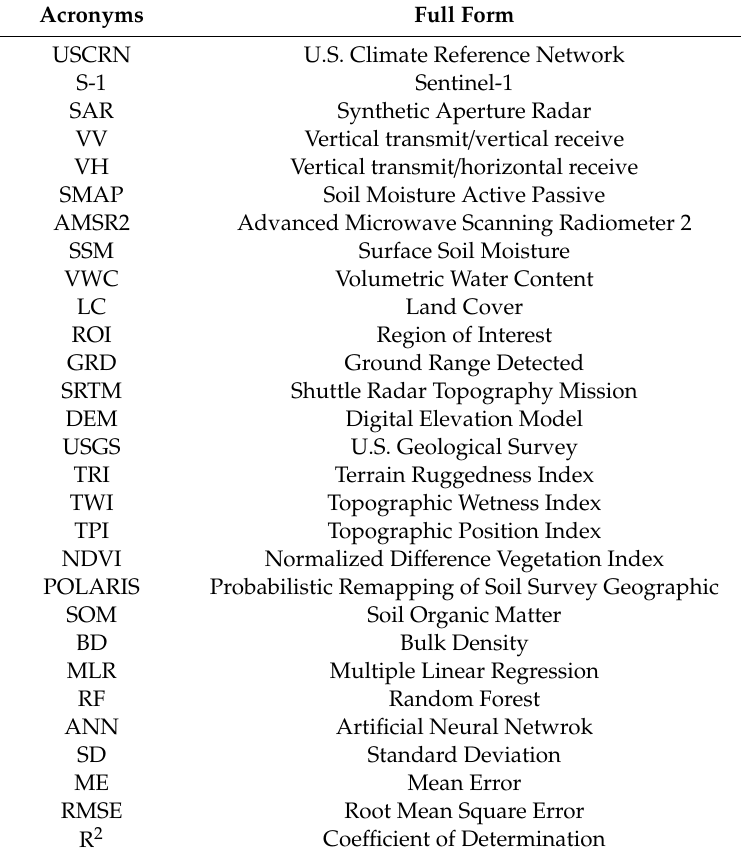
Table A1. List of acronyms used in the